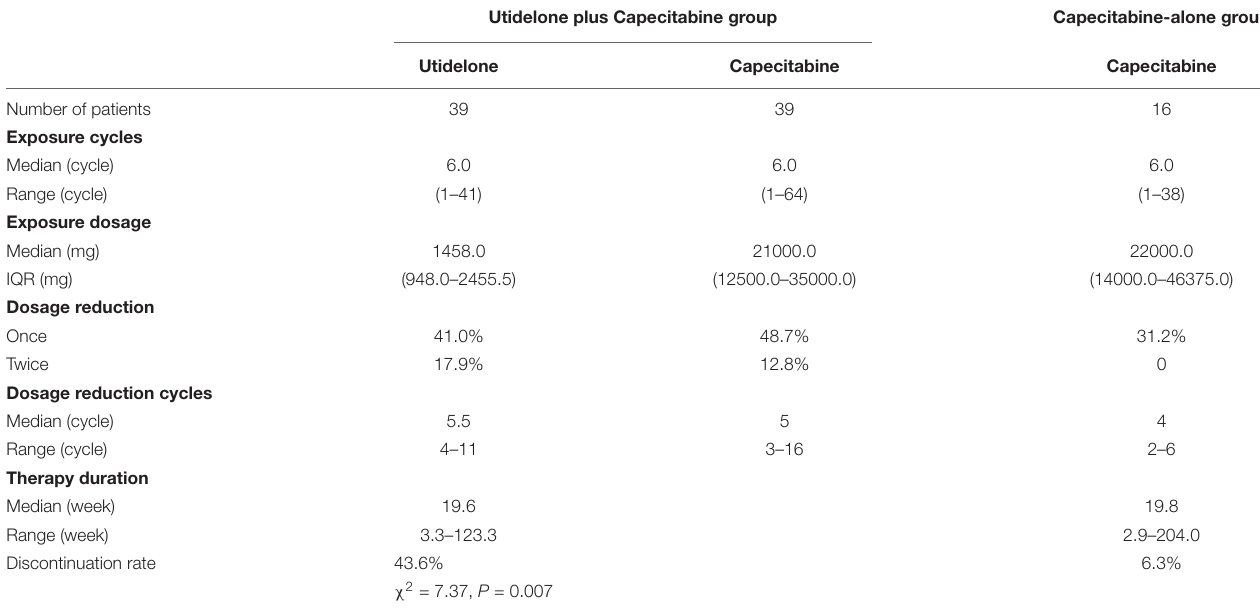
TABLE 3 | Exposure and dosage reduction of chemotherapy in utidelone plus capecitabine and capecitabine-alone